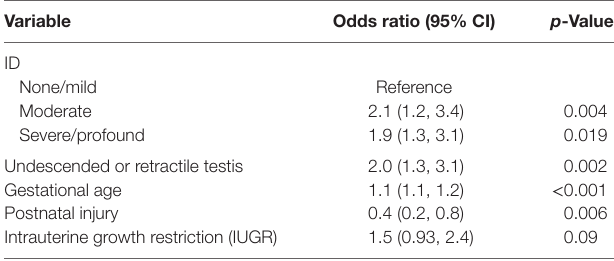
TaBle 6 | Stepwise logistic regression model of comorbidities associated with CNS and/or non-CNS congenital anomalies or genetic defect in boys with CP.